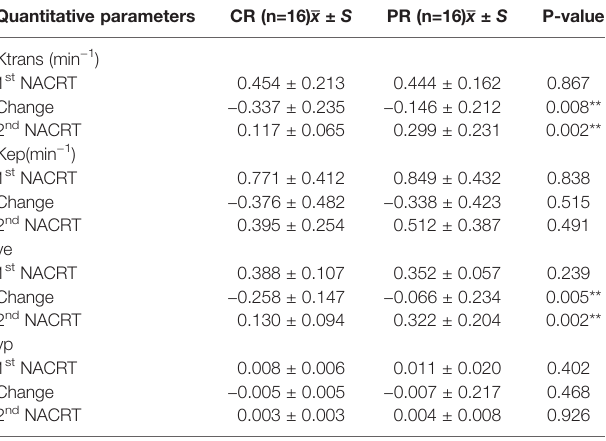
TABLE 1 | Differences between CR and PR for vascular permeability parameters. Quantitative parameters